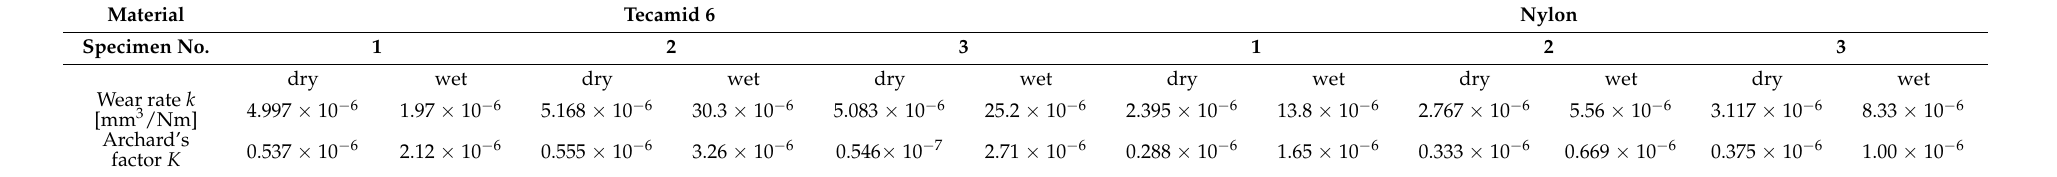
Table 6. Archard’s wear rate and wear factor depending on material